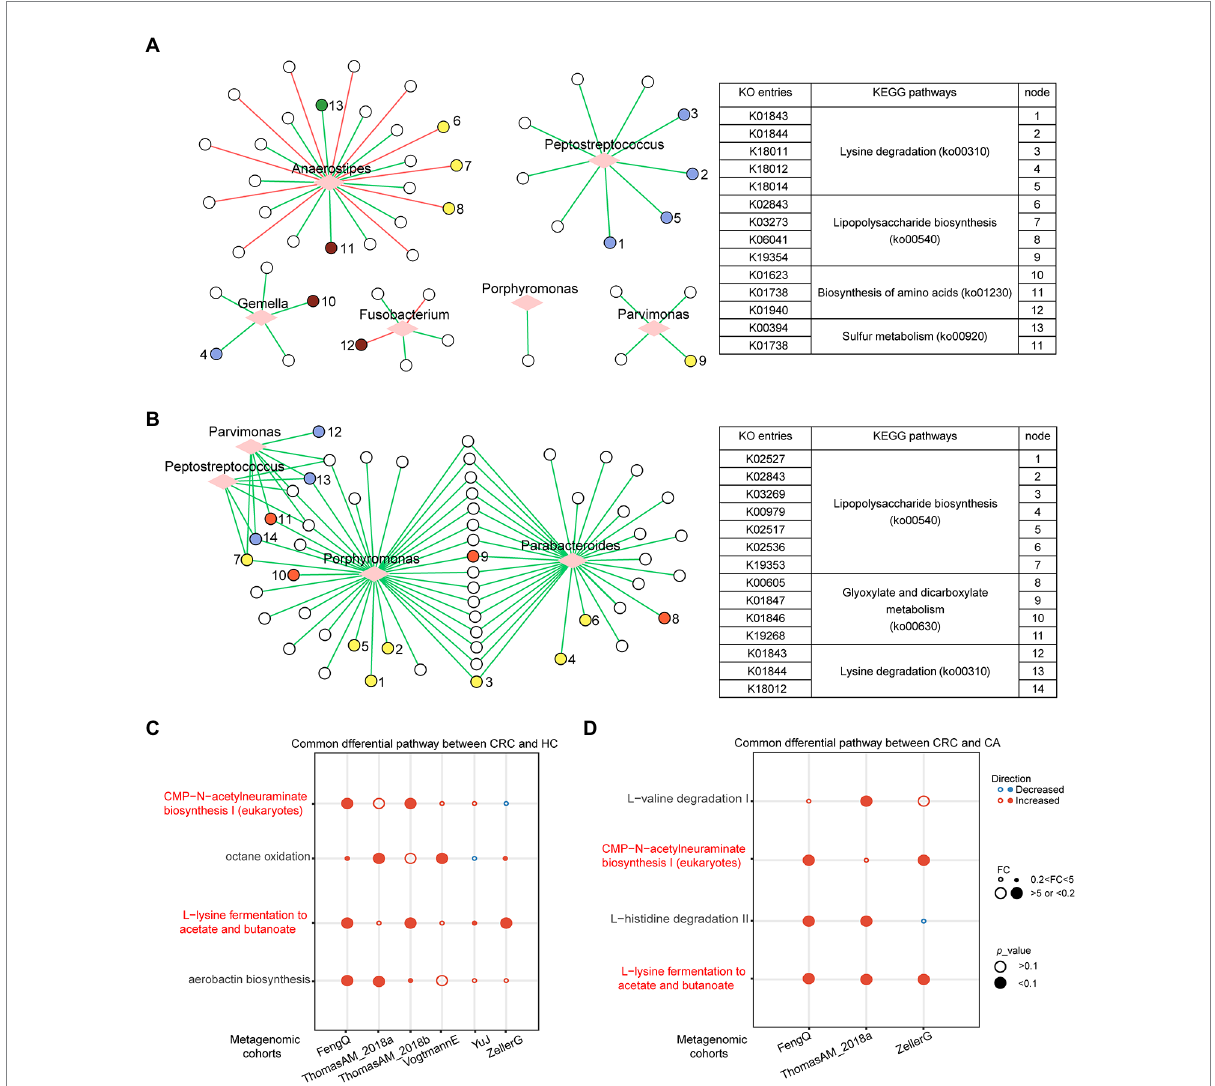
FIGURE 7 Functional gene family and pathways analysis in metagenomic sequencing datasets. (A) Correlation network between six bacterial markers and differential KO categories between CRC and HC. (B) Correlation network between four bacterial markers and differential KO categories between CRC and CA. The correlation was evaluated by Spearman. Circle represented KO categories and diamond represented bacterial markers. Red or green edges represented negative or positive correlation. Nodes with the same color share the same KEGG pathway. Consistently dysregulated pathways between CRC and HC (C) or CA (D) . The overlapped pathways were marked in